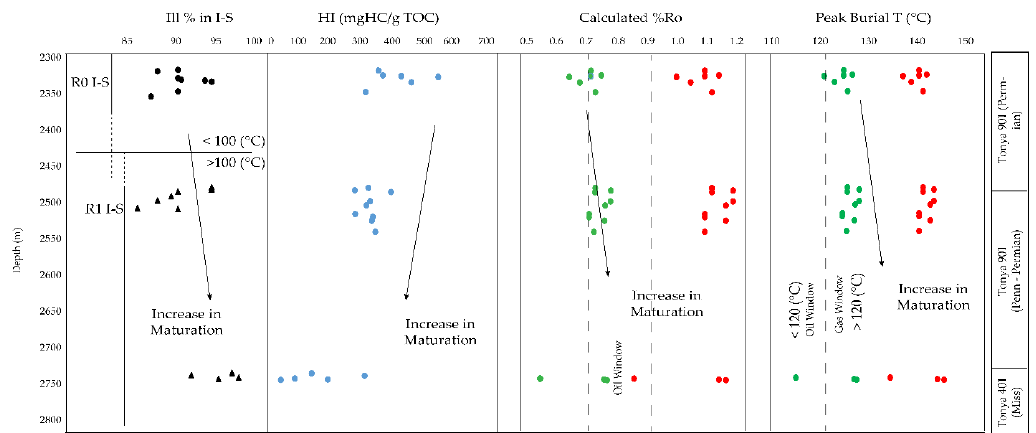
Figure 13. Maturation index data from three cores spanning the study interval. Progressive ordering of I-S corresponds well with an increase of temperature proxies with depth. Calculated %R o after Jarvie (2018) (calculated %R o = (0.0165 × Tmax) − 6.5143) (green dots) and after Lewan and Pawlewicz (2017) (calculated %R o = (0.022 × Tmax) − 8.57) (red dots). Calculated peak burial temperature (T (°C) = (ln(v%R o ) + 1.68) / 0.0124) after Barker and Pawlewicz (1994) [80].